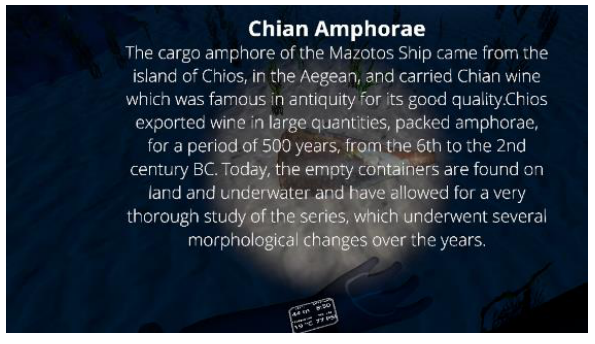
Figure 11. Archaeological asset